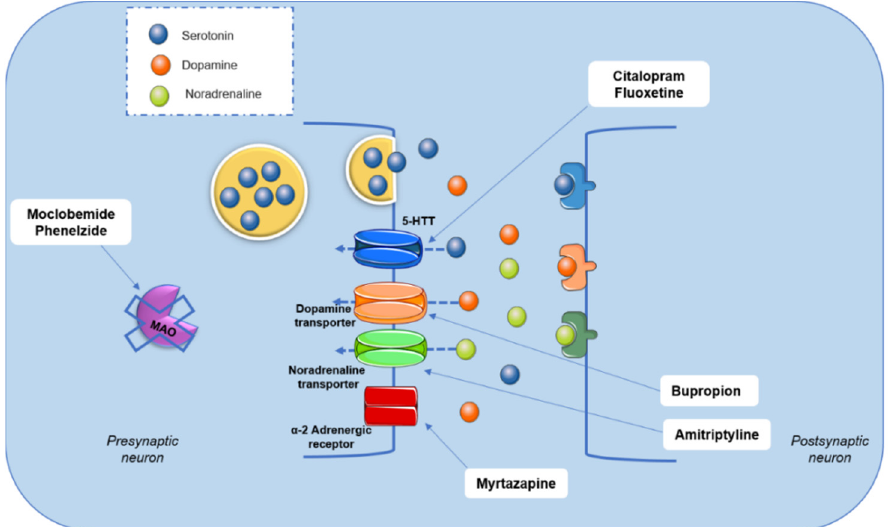
Figure 2. Mode of action of monoamine-modulating antidepressants. Selective serotonin reuptake inhibitors, such as fluoxetine, bind to the serotonin transporter (5-HTT) and block the reuptake of this neurotransmitter, whereas antidepressants, such as bupropion, belong to the group of noradrenaline and dopamine reuptake inhibitors. Tricyclic antidepressants, such as amitriptyline, prevent the reuptake of serotonin, dopamine, and noradrenaline in a non-specific manner by binding and blocking their transporters. The α 2 adrenergic receptor antagonists, such as mirtazapine, bind to these receptors, increasing noradrenaline levels. Monoamine oxidase (MAO) enzyme inhibitors, such as phenelzine, bind to isoforms of the enzyme, inhibiting its binding to monoamines, thereby blocking its enzymatic catalysis. Figure was created using images from server Medical Art (https://smart.servier.com) accessed on 16 August 2022, licensed under a Creative Commons Attribution 3.0.